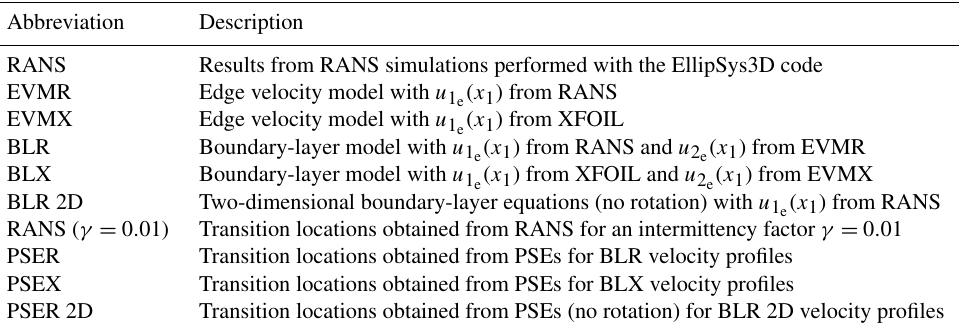
Table 3. Abbreviations of the employed methods.